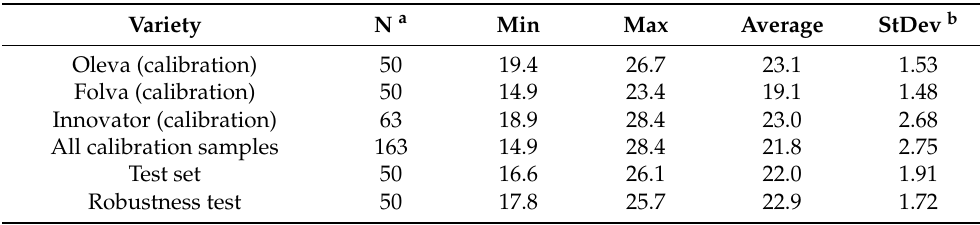
Table 1. Summary of statistics for reference measurements of DM (dry matter) in potatoes. All values are given in %